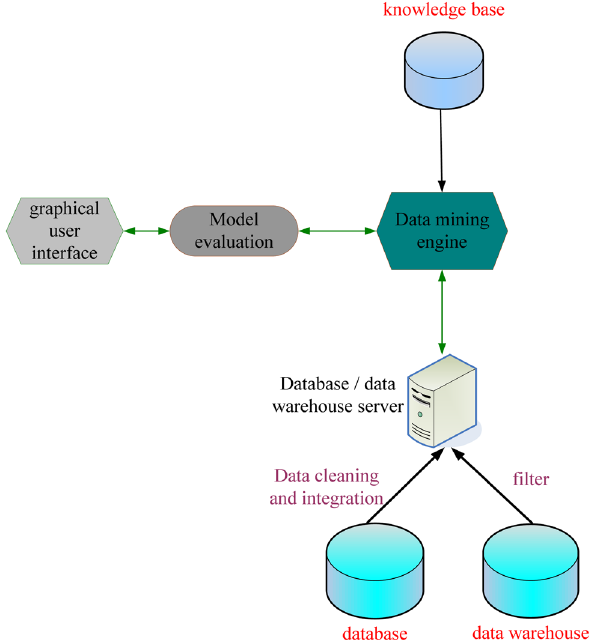
Figure 4: Data mining